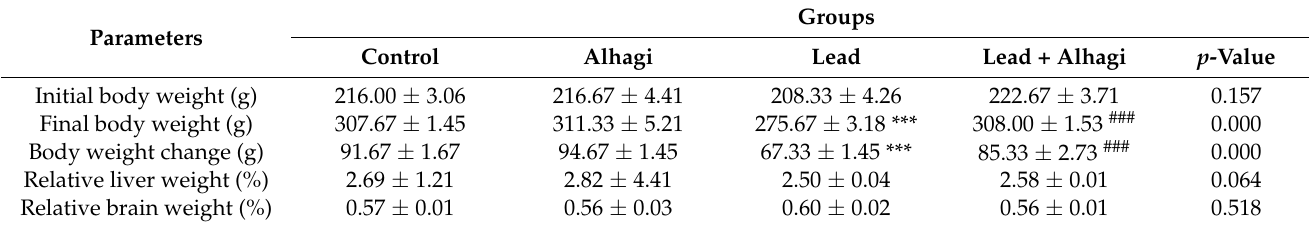
Table 3. Effect of A. maurorum extract (300 mg/kg BW, orally) on body weight change and relative liver and brain weights in rats exposed to lead (100 mg/kg BW, orally) daily for 3 months.